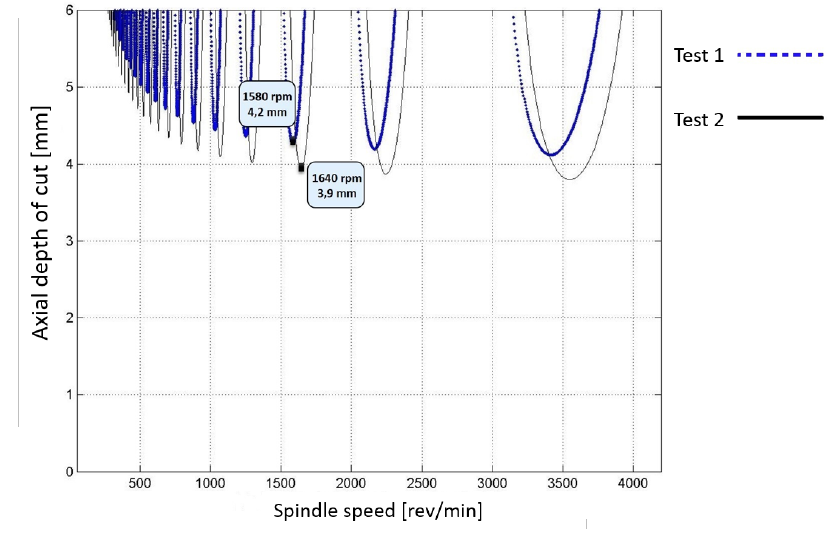
Fig. 5. Stability lobes diagram for experiments 1 and